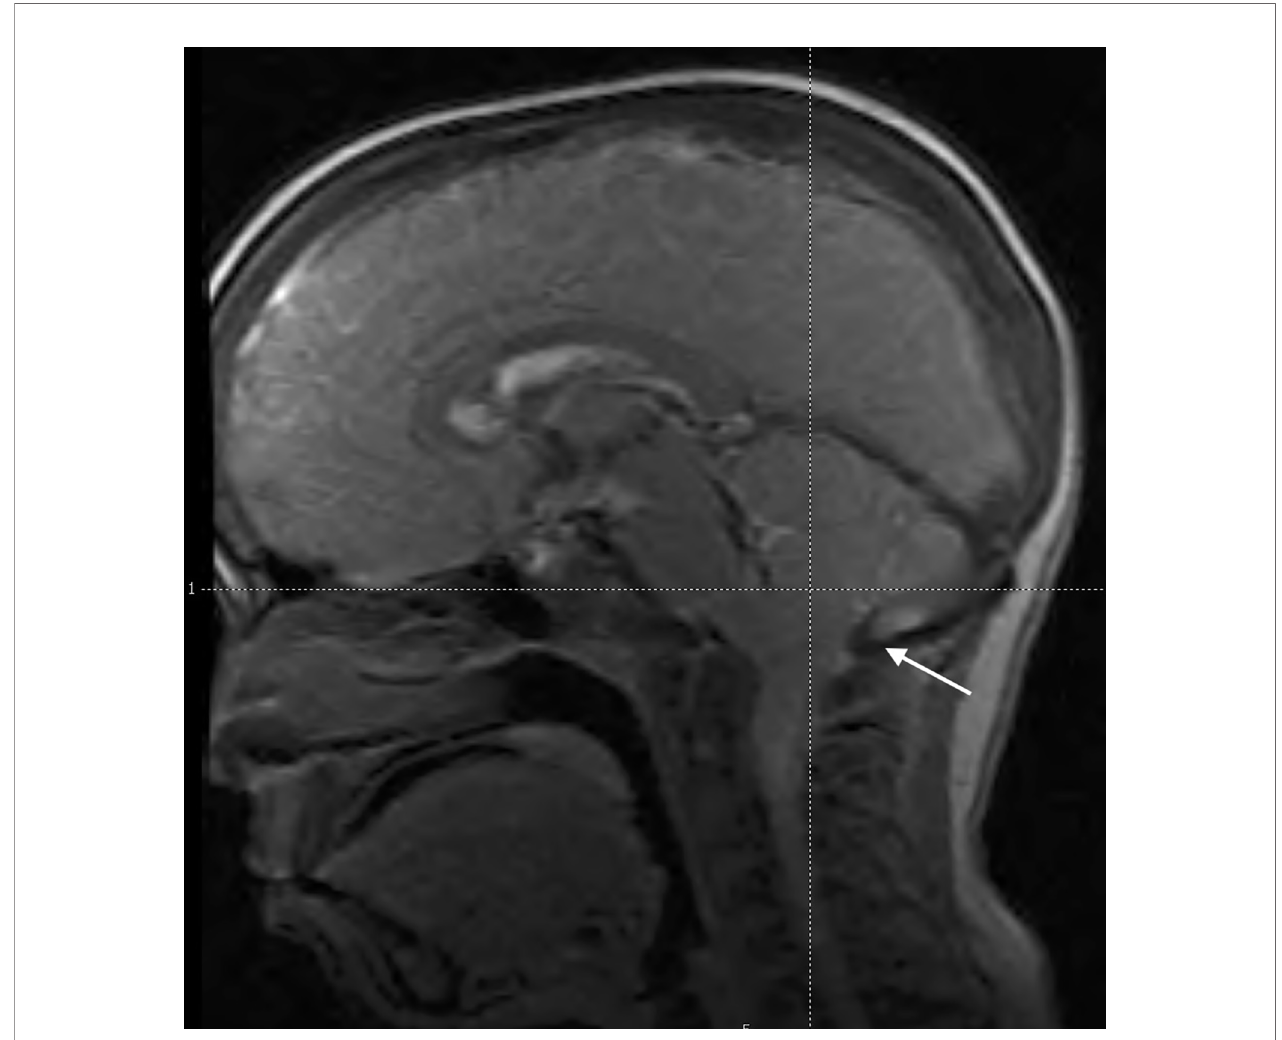
FIGURE 5 | Midsagittal magnetic resonance image of the head in an 11.5-year-old male patient with XLH showing caudal descent of the cerebellar tonsils through the foramen magnum (Arnold-Chiari 1 malformation) (white arrow). He reported transient headache. Scaphocephaly was also